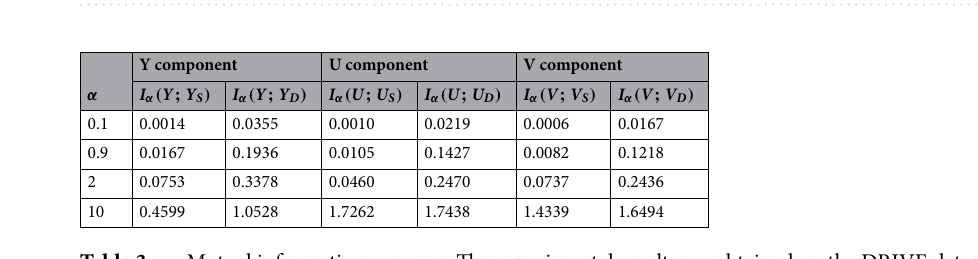
Table 3. α -Mutual information measure. The experimental results are obtained on the DRIVE dataset.